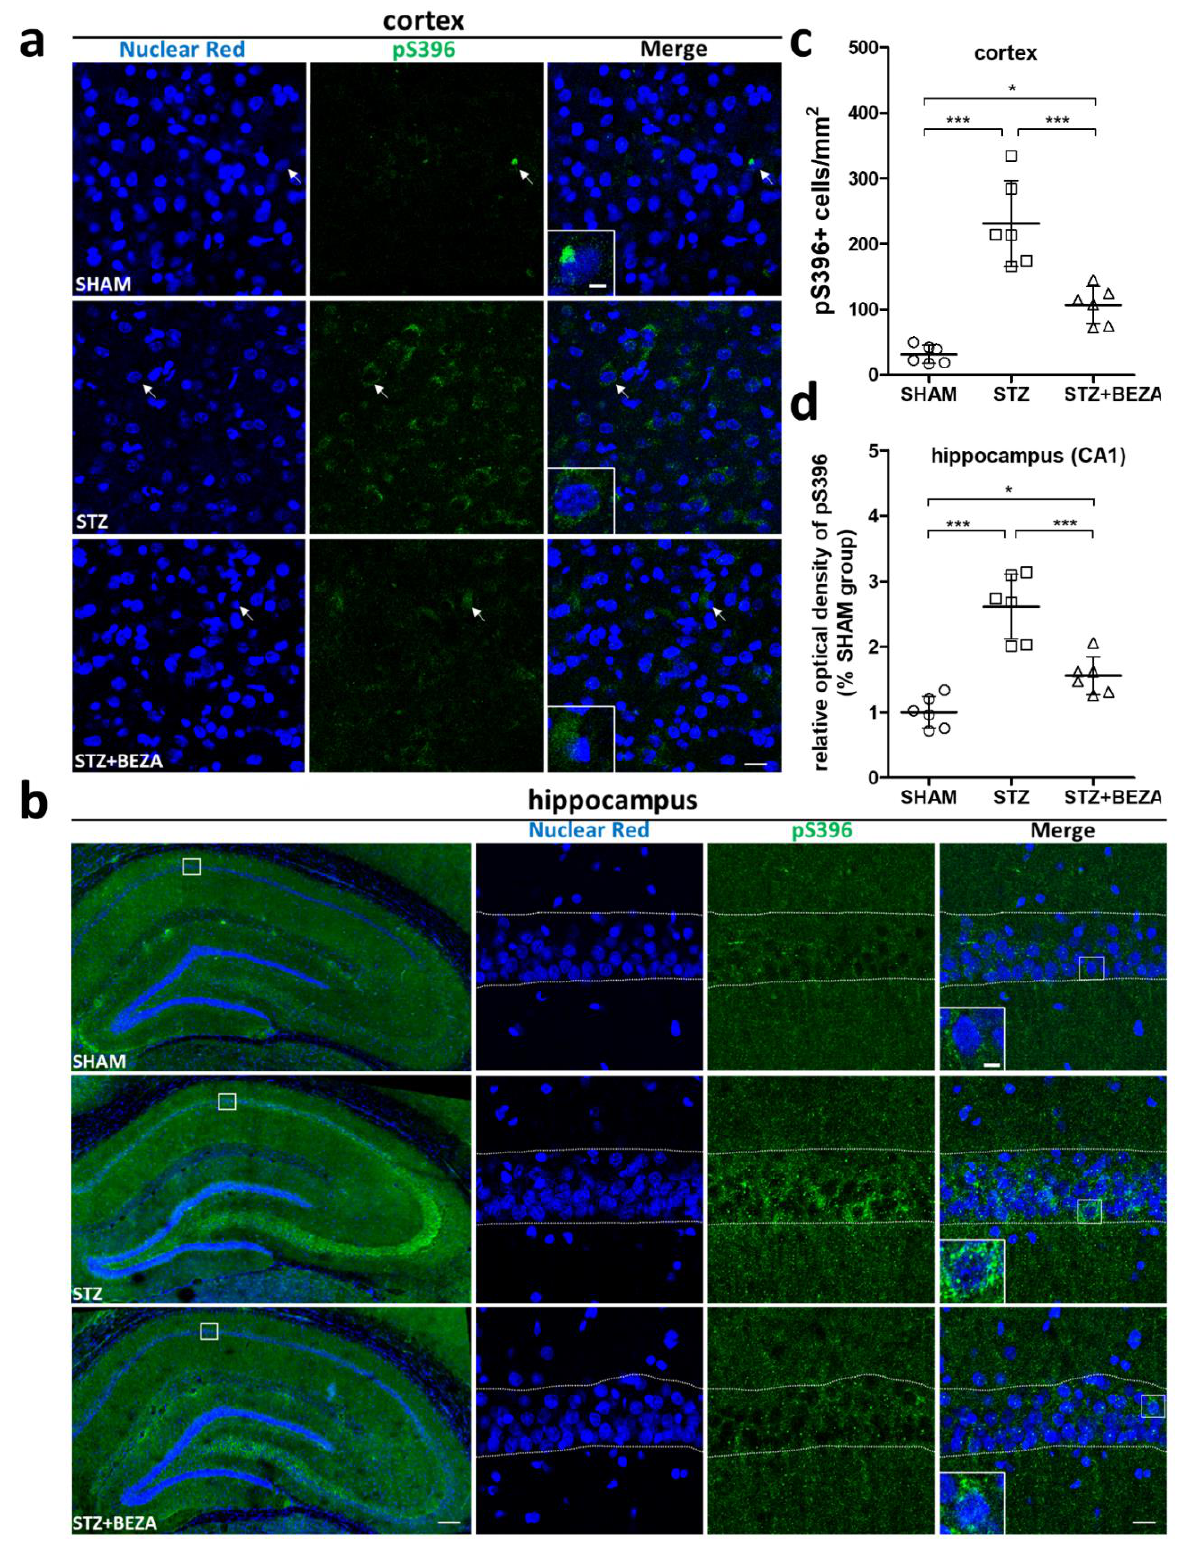
Figure 4. Bezafibrate reduced brain hyperphosphorylated tau protein accumulation in STZ-ICV- injected rats. Hyperphosphorylated tau protein was assessed by immunofluorescence staining with anti-pS396 antibody (green) and nuclear red (blue, as nuclear counterstain). The STZ group